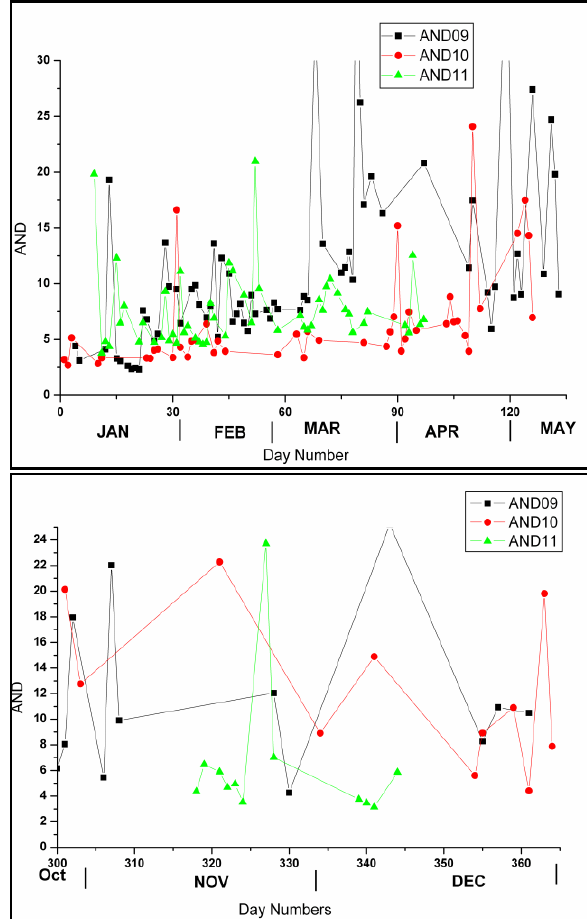
Figure-6: Three years annual variations for AND of Junge layer